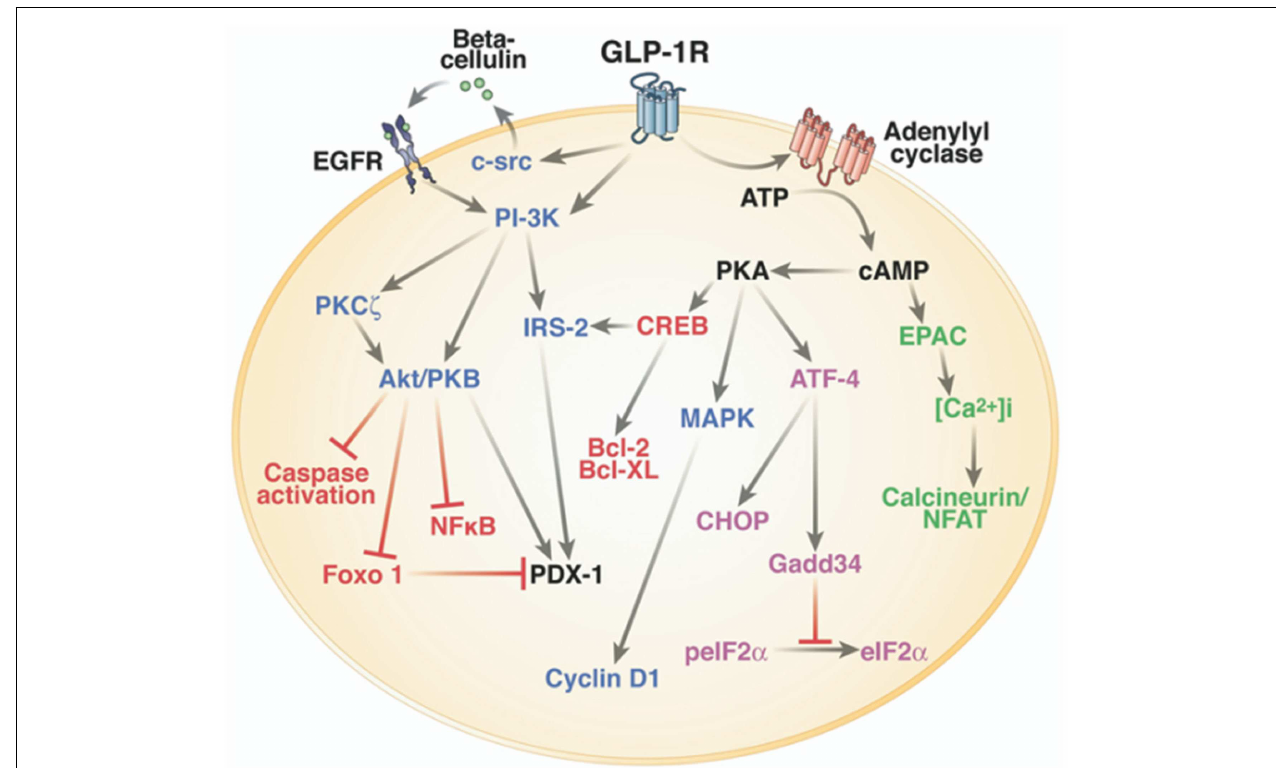
phosphatidylinositol-3 kinase (PI3K), Protein Kinase C ζ (PKC ζ ), Akt-protein kinase B, ERK1/2 (Extracellular Regulated Kinase, named also MAPK, Mitogen-Activated Protein Kinase) signaling pathways, and to the up-regulation of the expression of the cell cycle regulator cyclin D1. GLP-1R agonists also improve β -cell function and survival during endoplasmic reticulum stress (purple) by enhancing of ATF-4 translation in a cAMP- and PKA-dependent manner, promoting the up-regulation of the endoplasmic reticulum stress markers CHOP and GADD34 expression and the dephosphorylation of eIF2 α . Of note, there is considerable overlap between pathways induced by the GLP-1R activation. Reprinted from Gastroenterology (Baggio and Drucker,